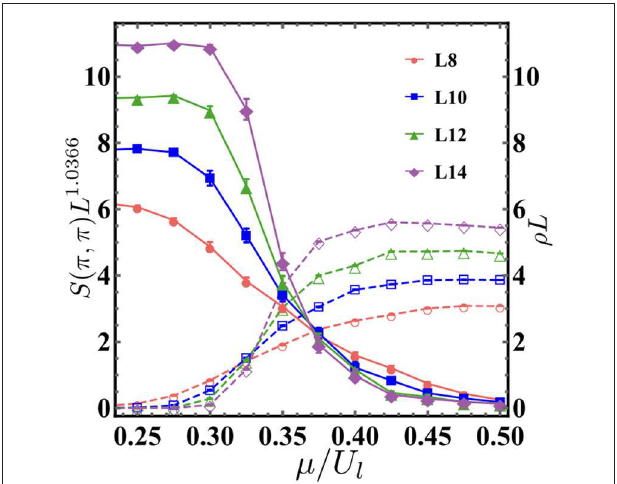
FIGURE 3 | Model 1 (cavity-mediated long-range interactions): the scaling of superfluid stiffness ρ L and structure factor S ( π , π ) L 1.0366 as a function of µ/ U l for different system sizes L = 8, 10, 12, and 14 (red dots, blue rectangles, green up triangles, and purple diamonds) at 1/ t = 2 and t / U l = 0.25. Solid lines represent the structure factor and dashed lines represent superfluid stiffness. The crossing of different solid curves marks the transition point at µ/ U l = 0.325 ± 0.01 for the density wave to supersolid phase transition, while the crossing of different dashed curves marks the transition point at µ/ U l = 0.368 ± 0.02 for the supersolid to superfluid phase transition.